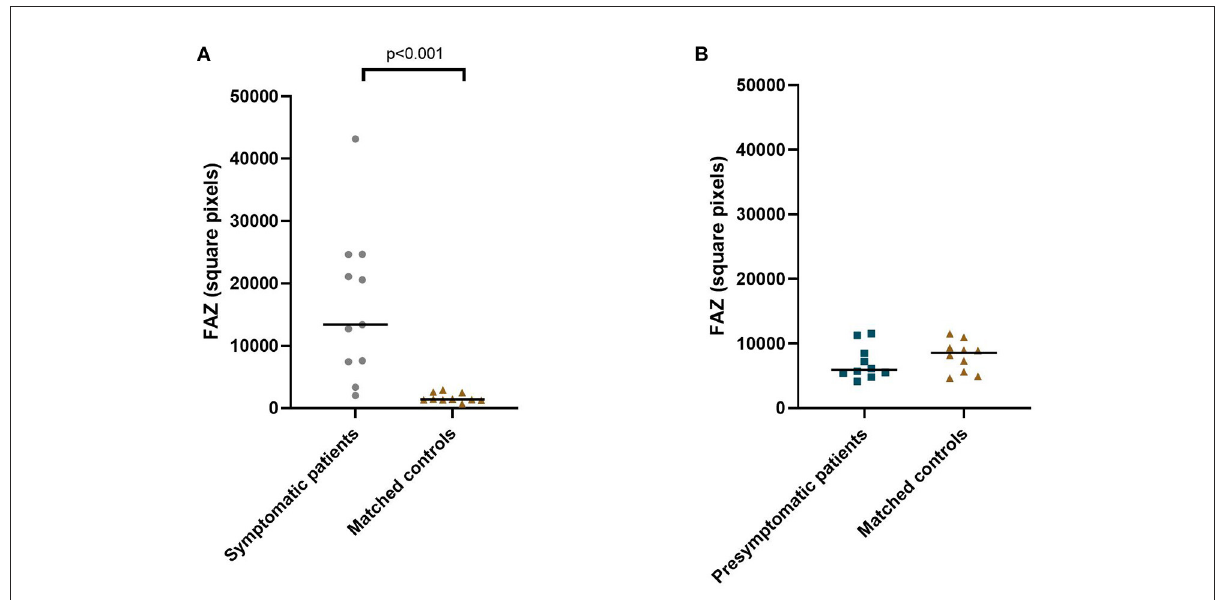
FIGURE2 Median foveal avascular zone area in symptomatic RVCL-S patients and controls (A) and presymptomatic RVCL-S patients and controls (B)